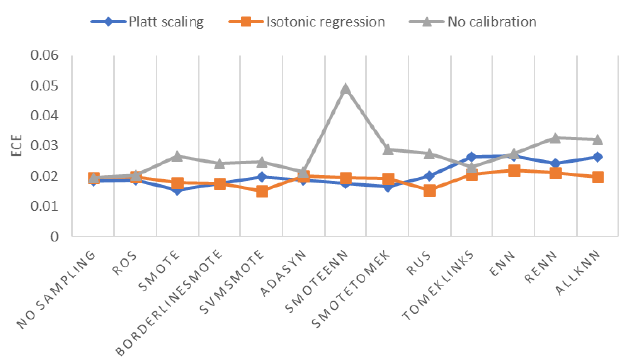
Figure 9. ECE of different sampling methods and probability calibration methods.